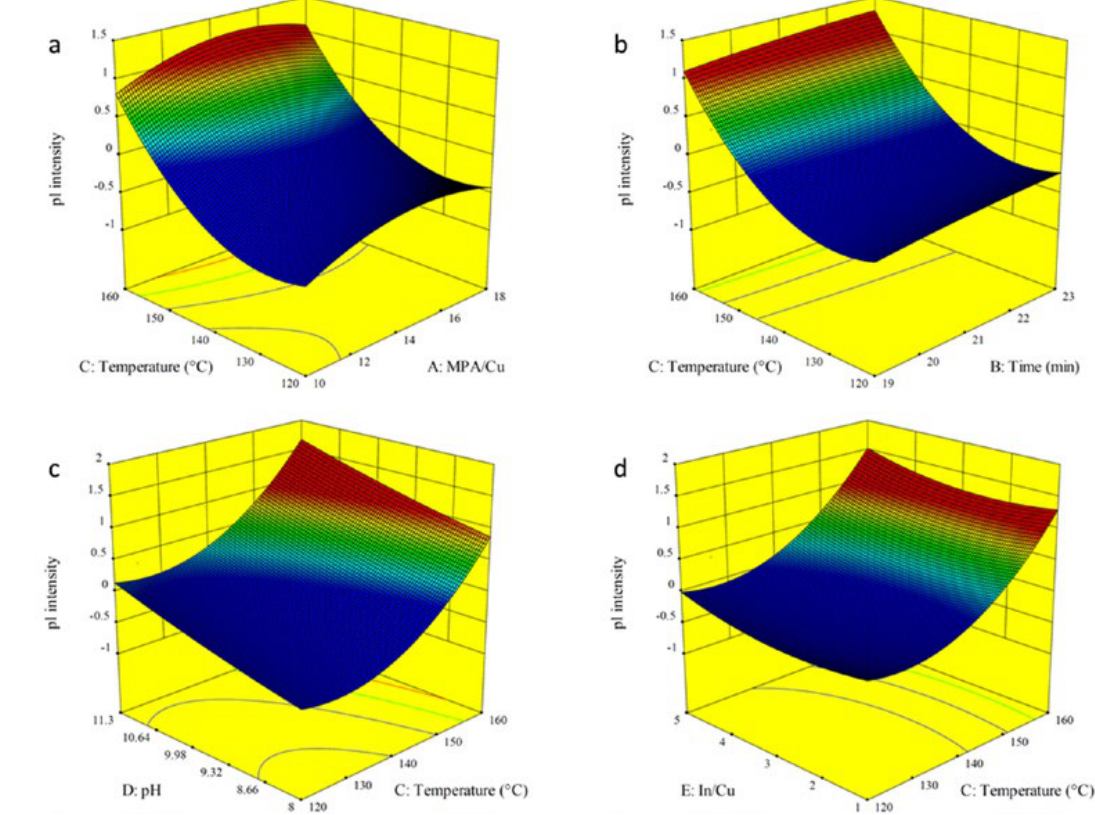
Fig. 5. 3D response surface plots of PL intensity as a function of (a) temperature and MPA/Cu (b) temperature and time, (c) temperature and pH (d) temperature and In/Cu at constant values of other variables